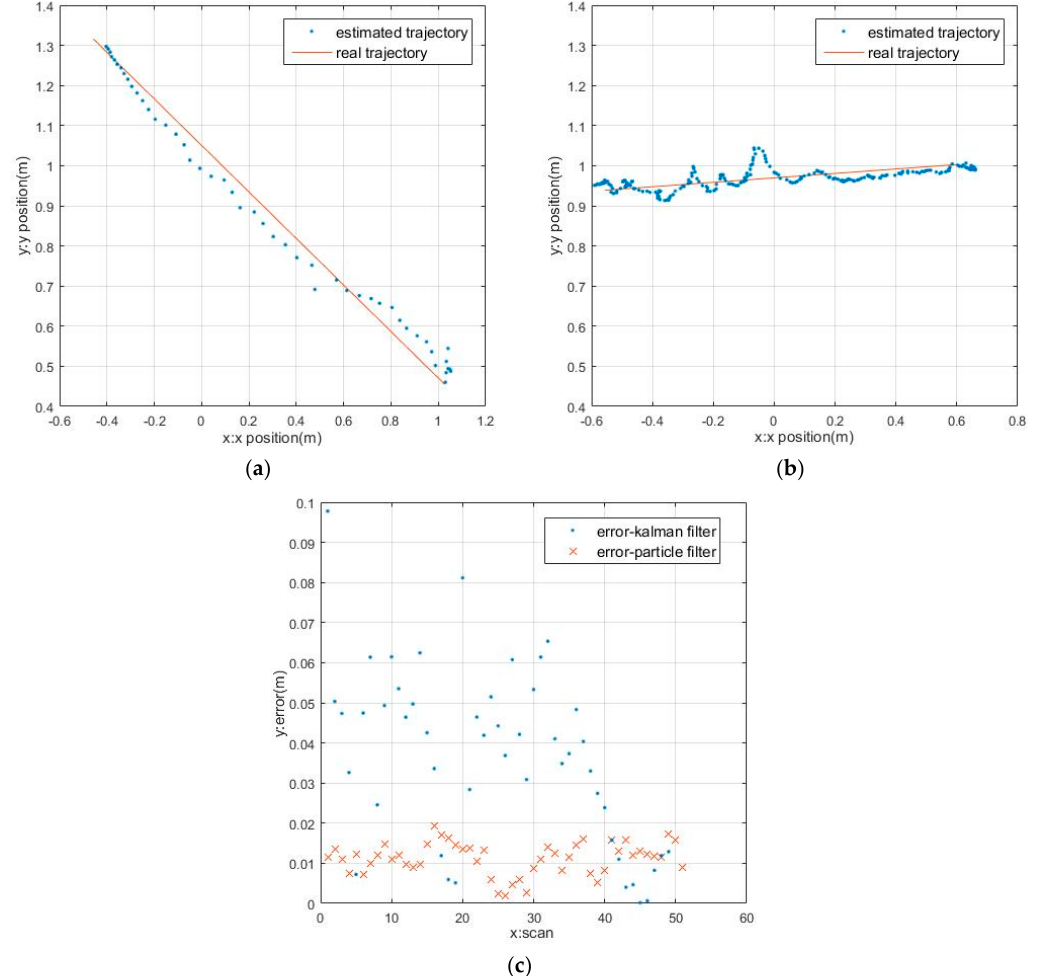
Figure 16. The tracking results in rectilinear motion: ( a ) Results with KF; ( b ) Results with adaptive PF; ( c ) The error of KF and PF.